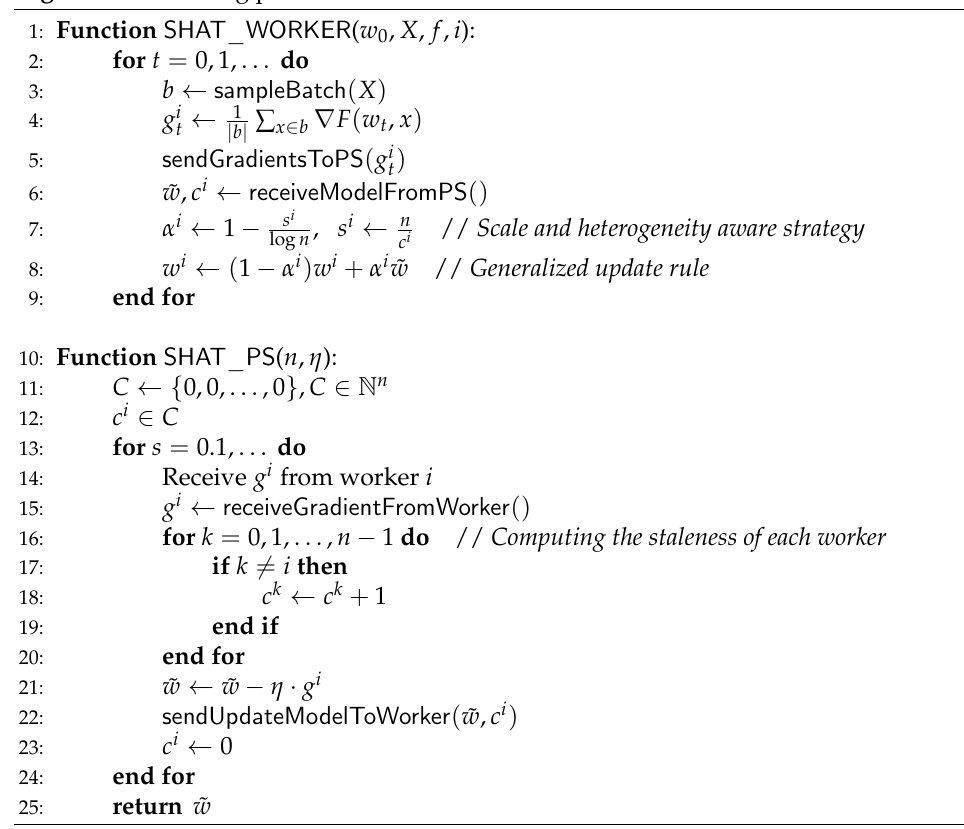
Algorithm 1 Training processes of a worker and PS in